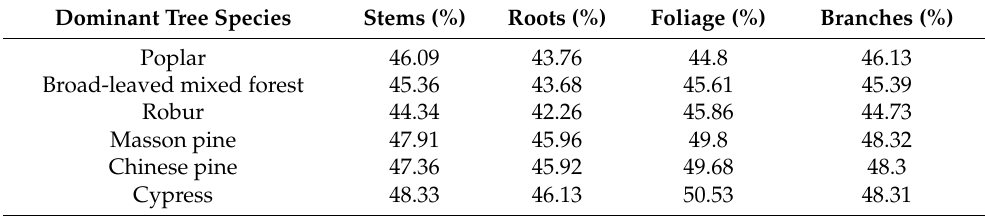
Table 2. Carbon content of different organs of dominant tree species in Henan Province. Dominant Tree Species Stems (%) Roots (%) Foliage (%) Branches (%) Poplar Broad-leaved mixed